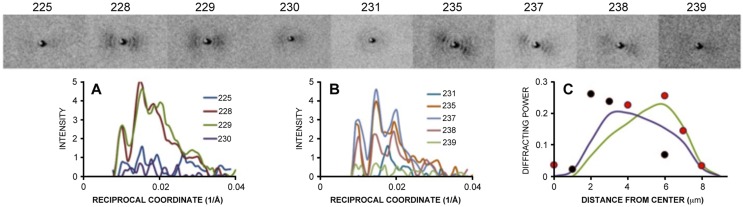
Diffraction patterns across fiber breadth demonstrate lamellar versus in-plane scatter.(Above) Diffraction patterns at beam positions #225, 228, 229, 230, 231, 235, 237, 238, and 239. (A, B) Observed intensity distributions as a function of reciprocal coordinate (1/Å) for patterns #225, 228, 229, and 230 (A), and for #231, 235, 237, 238, and 239 (B). (C) Diffracting power (defined in Text S1, Diffracting power of myelinated fiber) as a function of the distance from the center for the observed patterns graphed in panel (A) (black circles) and in panel (B) (red circles), and calculated values based on the geometry of the fiber and beam, and where the beam is incident on the fiber (see Fig. S3).